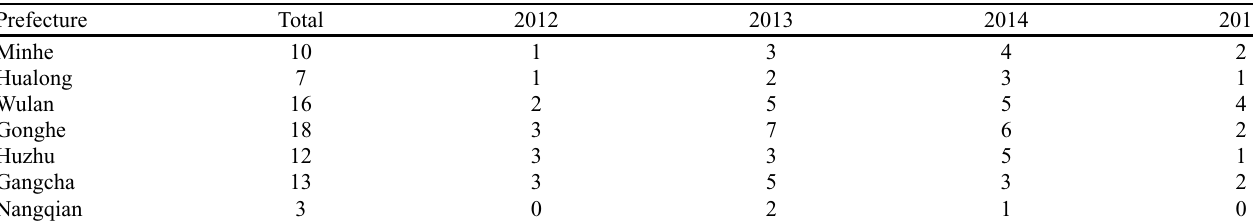
Table 2. The number of F. hepatica infestation positive sheep herds in Qinghai Province.